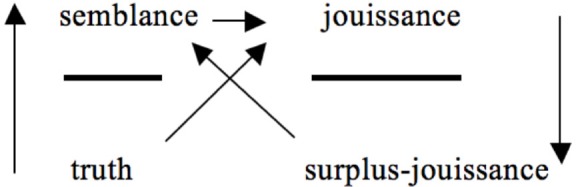
Overall structure of the discourses Lacan discerns in Seminar XIX (based on Lacan, 1971–1972, p. 67, 193; Lacan, 1972, p. 40).